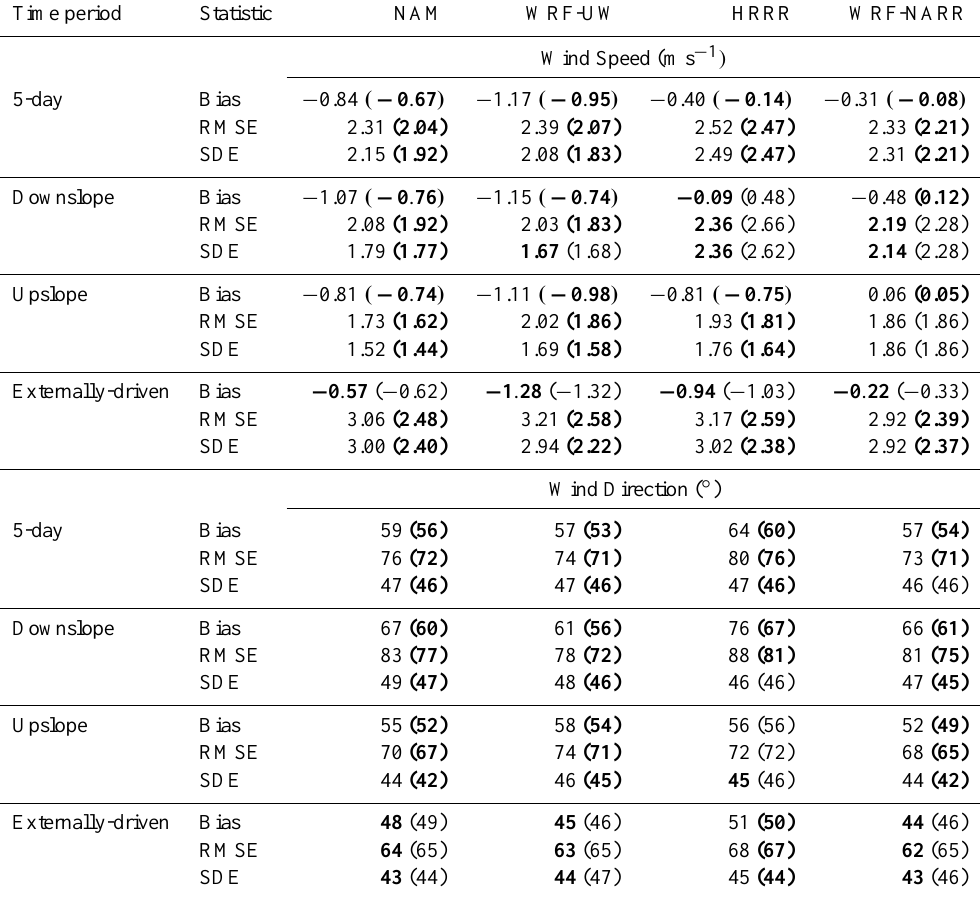
Table 2. Model mean bias, root mean square error (RMSE), and standard deviation of errors (SDE) for surface wind speeds and directions during the 5-day evaluation period at Big Southern Butte. Downscaled values are in parentheses. Smaller values are in bold. The 5-day period includes the Downslope, Upslope, and Externally driven time